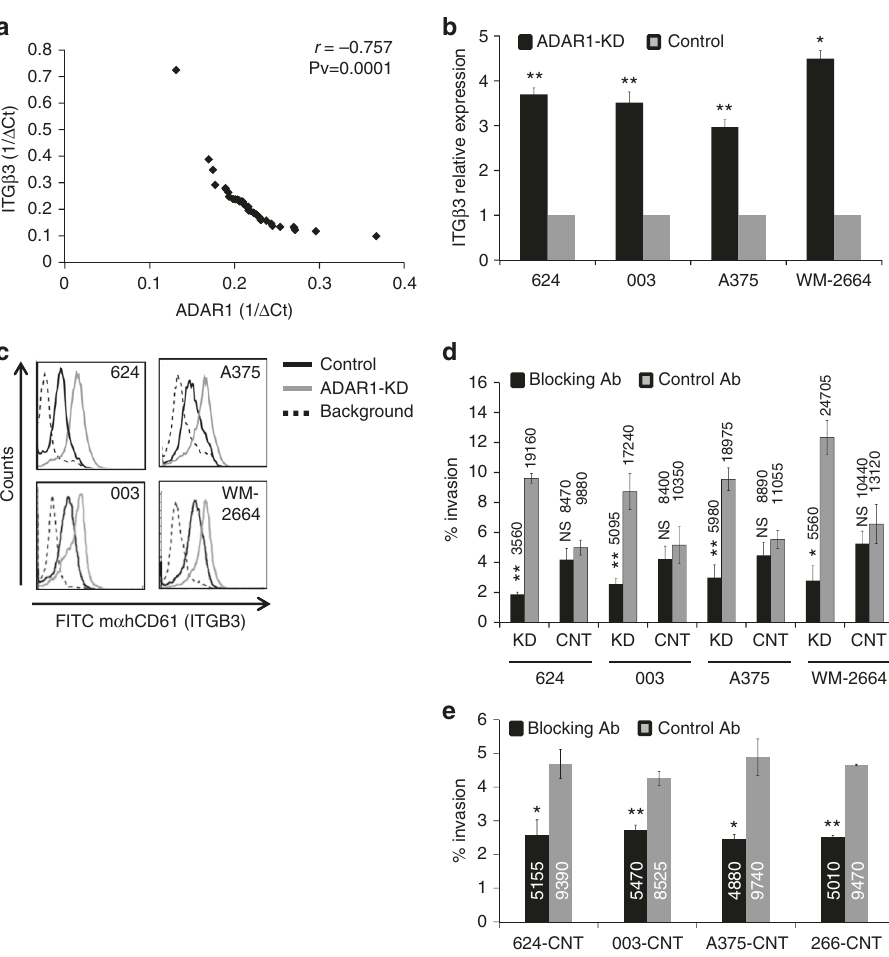
Fig. 2 ADAR1-regulated invasion is mediated by ITGB3. a Normalized ADAR1 and ITGB3 expression level in 38 low-passage primary cultures of metastatic melanoma presented as 1/ Δ Ct. Correlation was calculated using Pearson test. b ITGB3 mRNA levels (qRT-PCR) after silencing of ADAR1 with shRNA (ADAR1-KD) or negative control (control) in four melanoma lines. Results are expressed as fold above negative control. The mean ± SE of three experiments on independent RNA puri fi cations, each performed in triplicates, is shown. c Surface levels of ITGB3 expression, tested by fl ow cytometry in ADAR1-KD or control of each of the indicated cell lines. Background is isotype control; ADAR1-KD increased invasion is inhibited by blocking of ITGB3 function. d Stable ADAR-KD (KD) and control (CNT) cell lines or e control cell lines only were pre-incubated for 1 h with 10 or 30 µ g/ml, respectively, anti-ITGB3 blocking antibody (blocking AB) or control IgG (control AB) and plated on the upper chamber of Boyden chamber assay. The number of invaded cells was evaluated with XTT standardized assay 24 h post seeding. Numbers in the bars represent the absolute cell count of invading cells. Data are presented as the means ± SD from three independent experiments. Statistical signi fi cance was determined by Student ’ s t -tests. * P < 0.05, ** P <